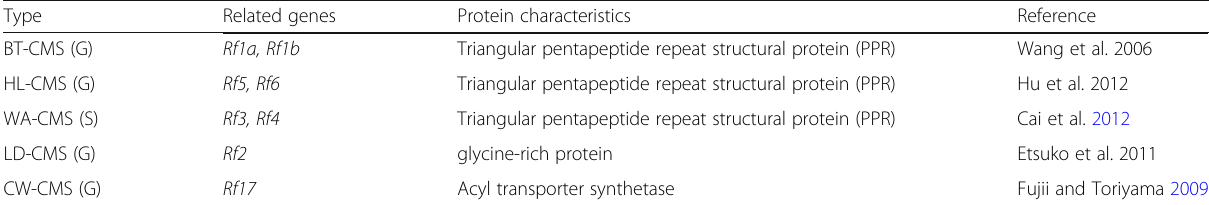
Table 3 Restorers of fertility for CMS in